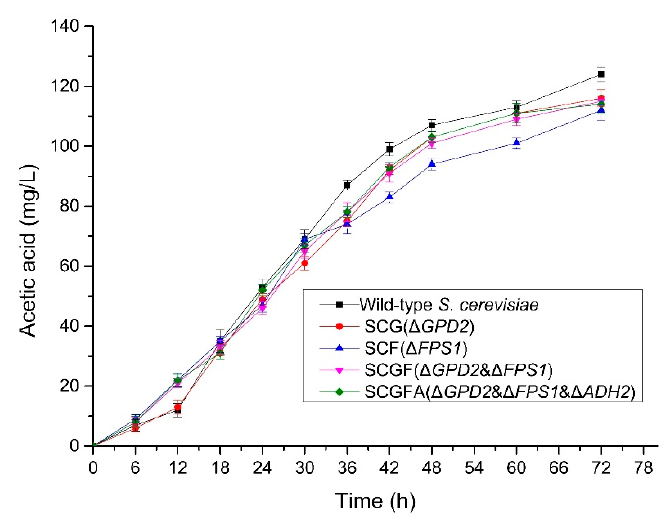
Figure 8. Acetic acid contents of the wild-type and S. cerevisiae transformants.